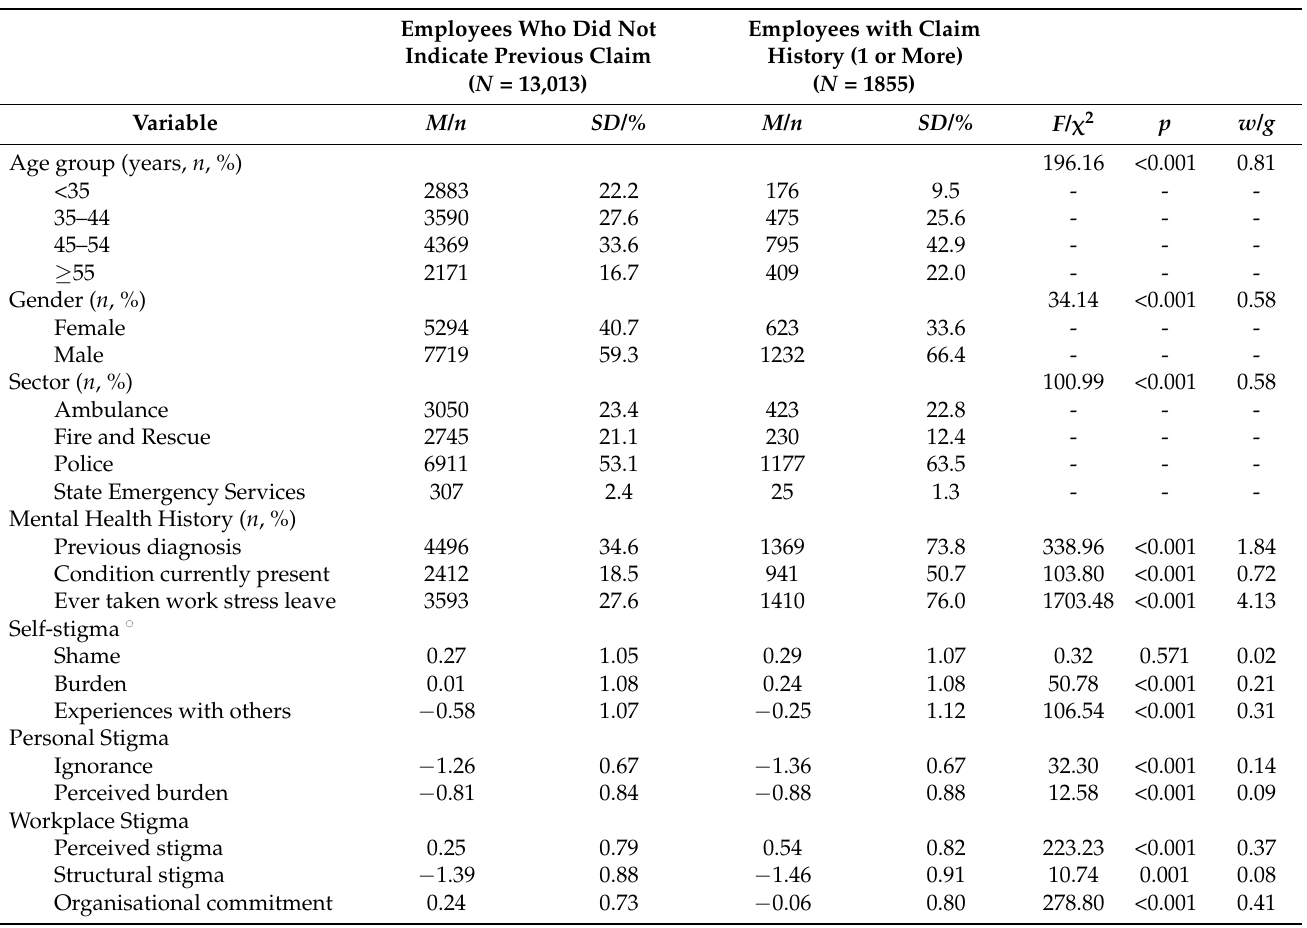
Table 1. Sample Characteristics and Between-Group Statistics on Key Variables, Comparing Employ- ees who reported Making One or More Claims with Employees who have never made a Claim for Psychological Injuries Obtained at Work.